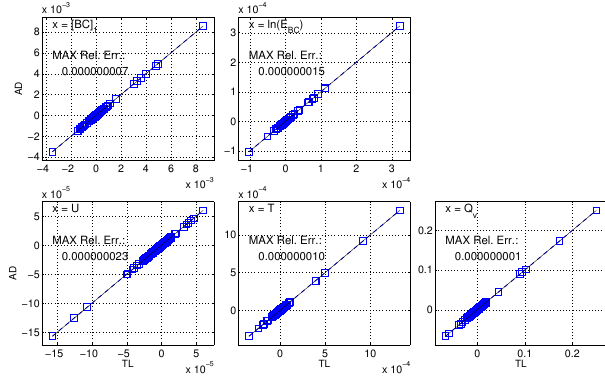
Figure 1. Comparison of ADM to TLM evaluations of ∂ [BC 1 ] ∂ [BC 2 ] for 300 derivatives for each denominator variable. ∂ x